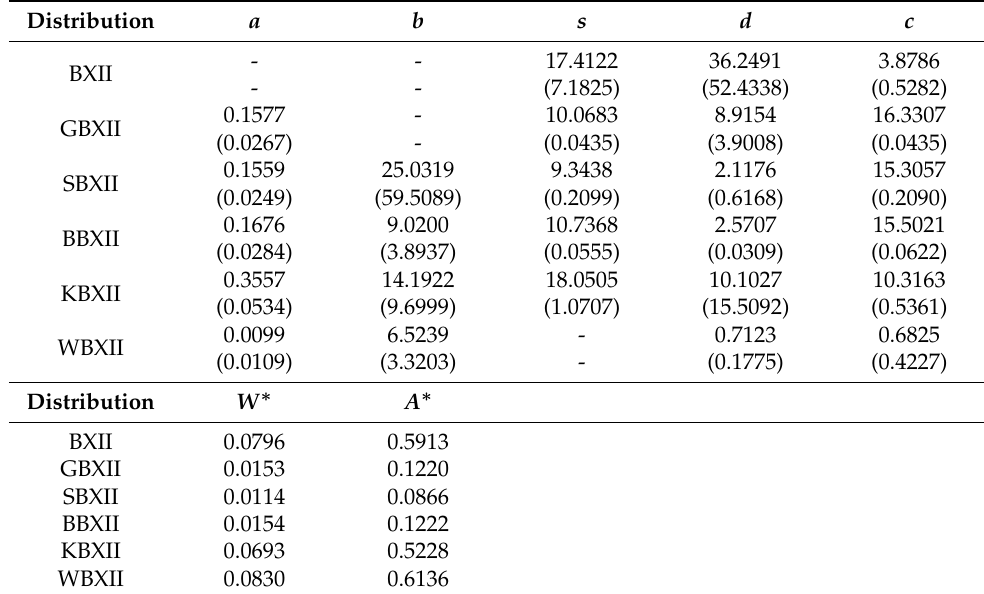
Table 4. Results from the fitted models to the turbocharger data.